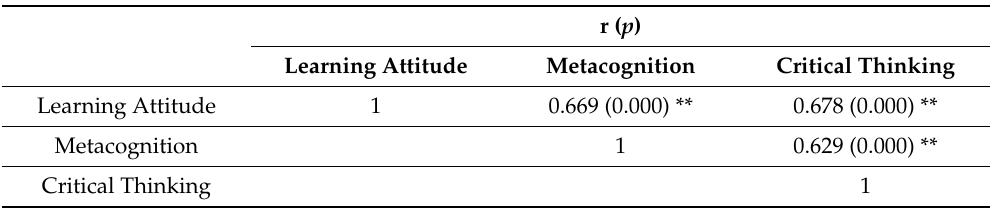
Table 2. Correlation between variables.